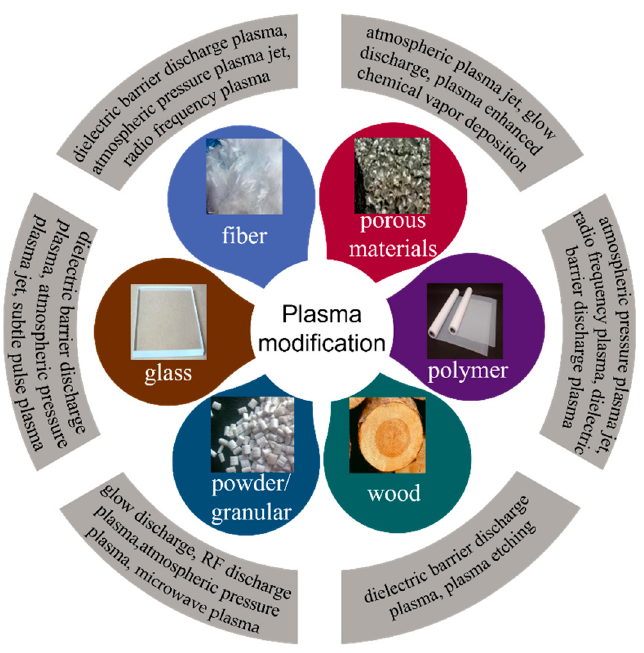
Figure 1. Schematic diagram of plasma treatment of different materials.